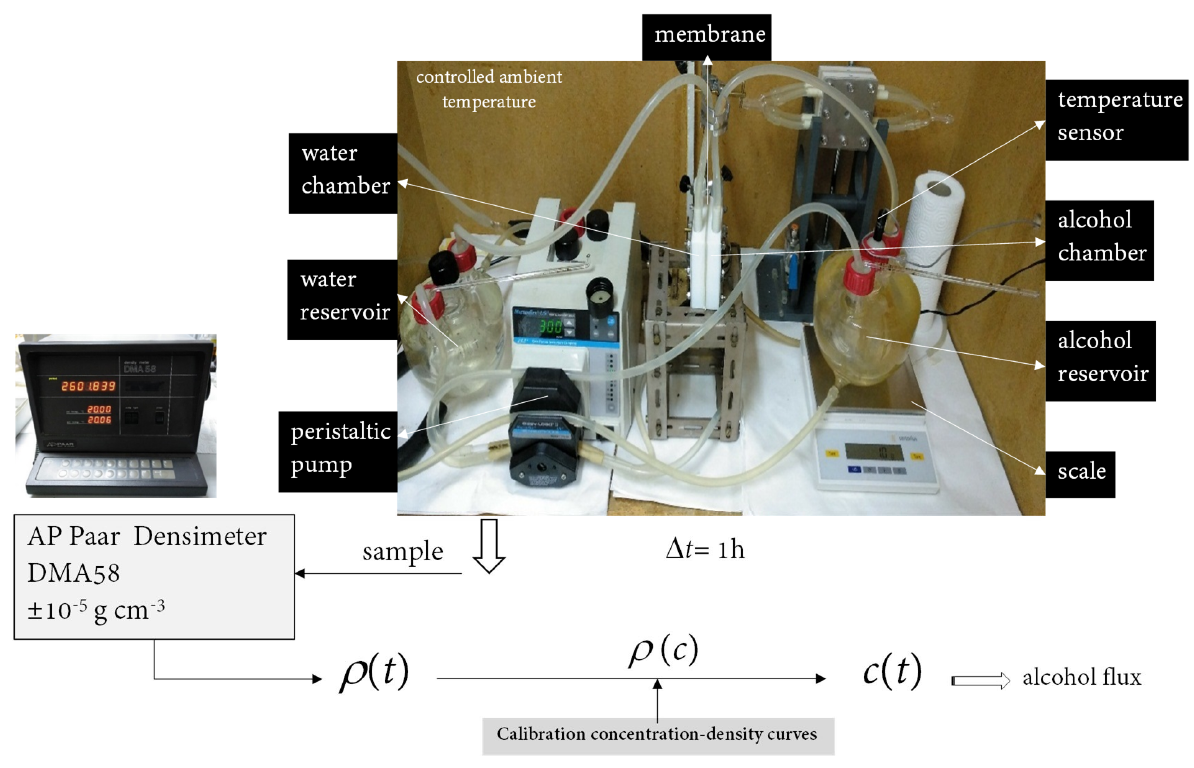
Figure 1. Experimental device used to estimate membrane alcohol permeability. With methanol, a test was also carried out using pure alcohol as initial solutions in the alcohol